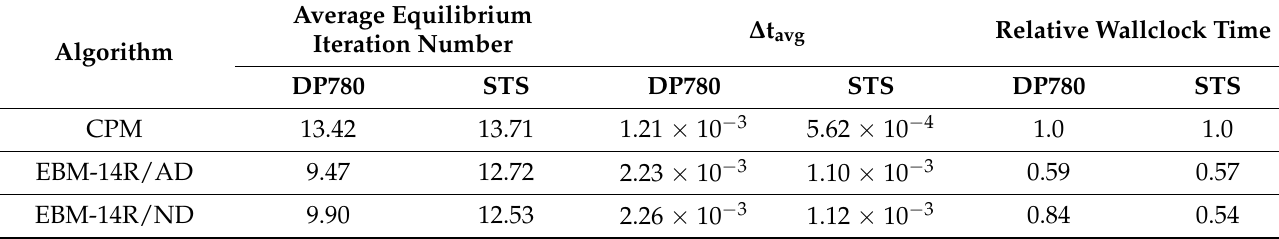
Figure 14. ( a ) Springback results of DP780 and STS at ( a , b ) section A, ( c , d ) section B and ( e , f ) section C. Table 8. The averaged equilibrium iteration number, the averaged time increment and the relative wallclock time during the forming step.